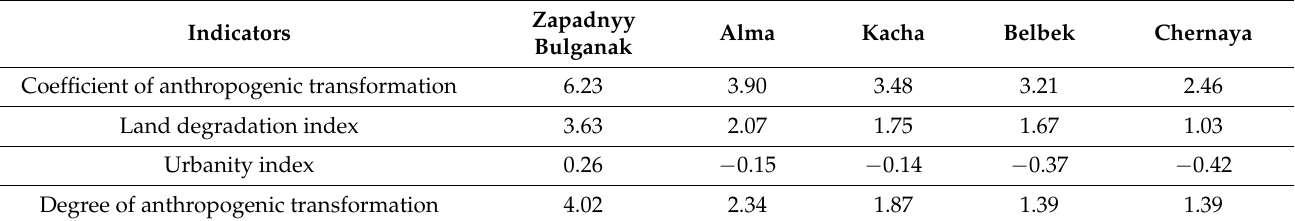
Table 2. Comparison of the values of indicators characterizing the transformation of the river basins of the northwestern slope of the Crimean Mountains (Zapadnyy Bulganak, Alma, Kacha, Belbek, and Chernaya